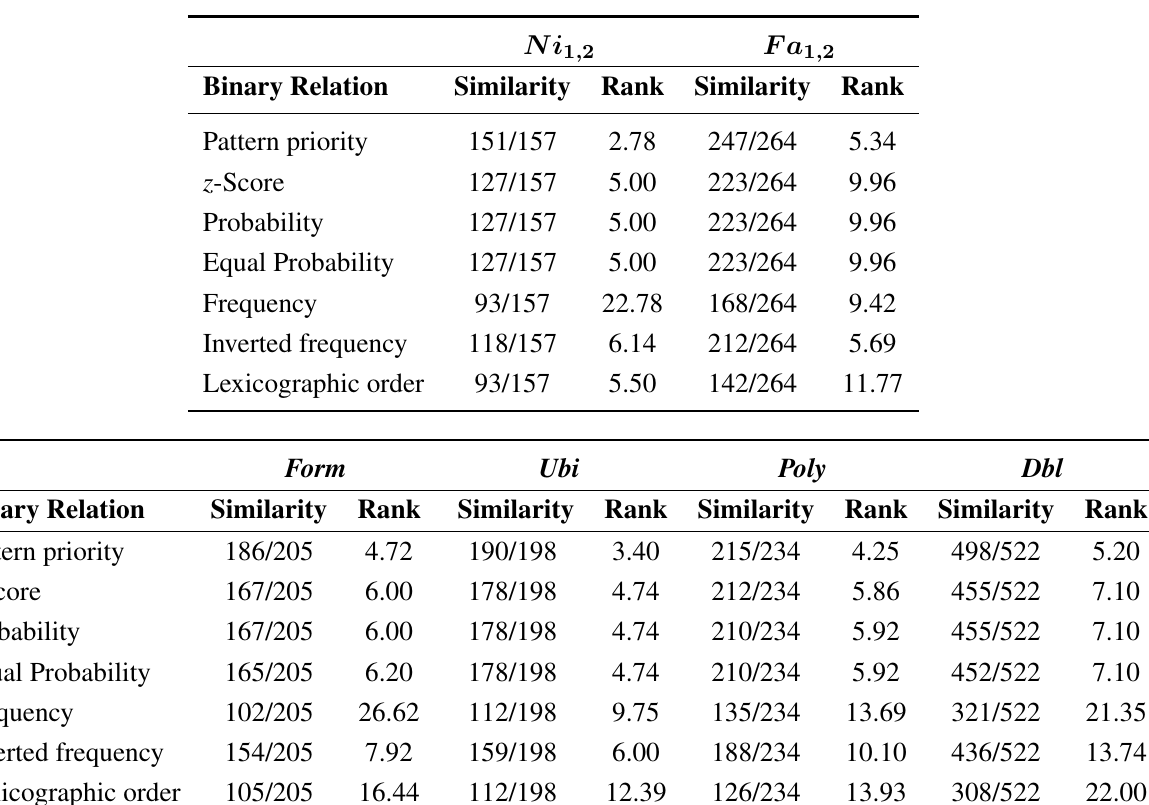
Table 4. Comparison of performance between different binary relations applied to the underlying patterns: Pattern priority, z -score, probability with distribution based on the amino acid frequencies in s , probability with no background ( i.e. , each amino acid scores 1 / 20 ), frequency of patterns in s , inverse frequency and the lexicographic order of occurrences. For each family, we summed up the maximum similarity with the two representative patterns for all quorums. Similarly, in the column rank, we show the average rank of the closest candidates to these patterns.